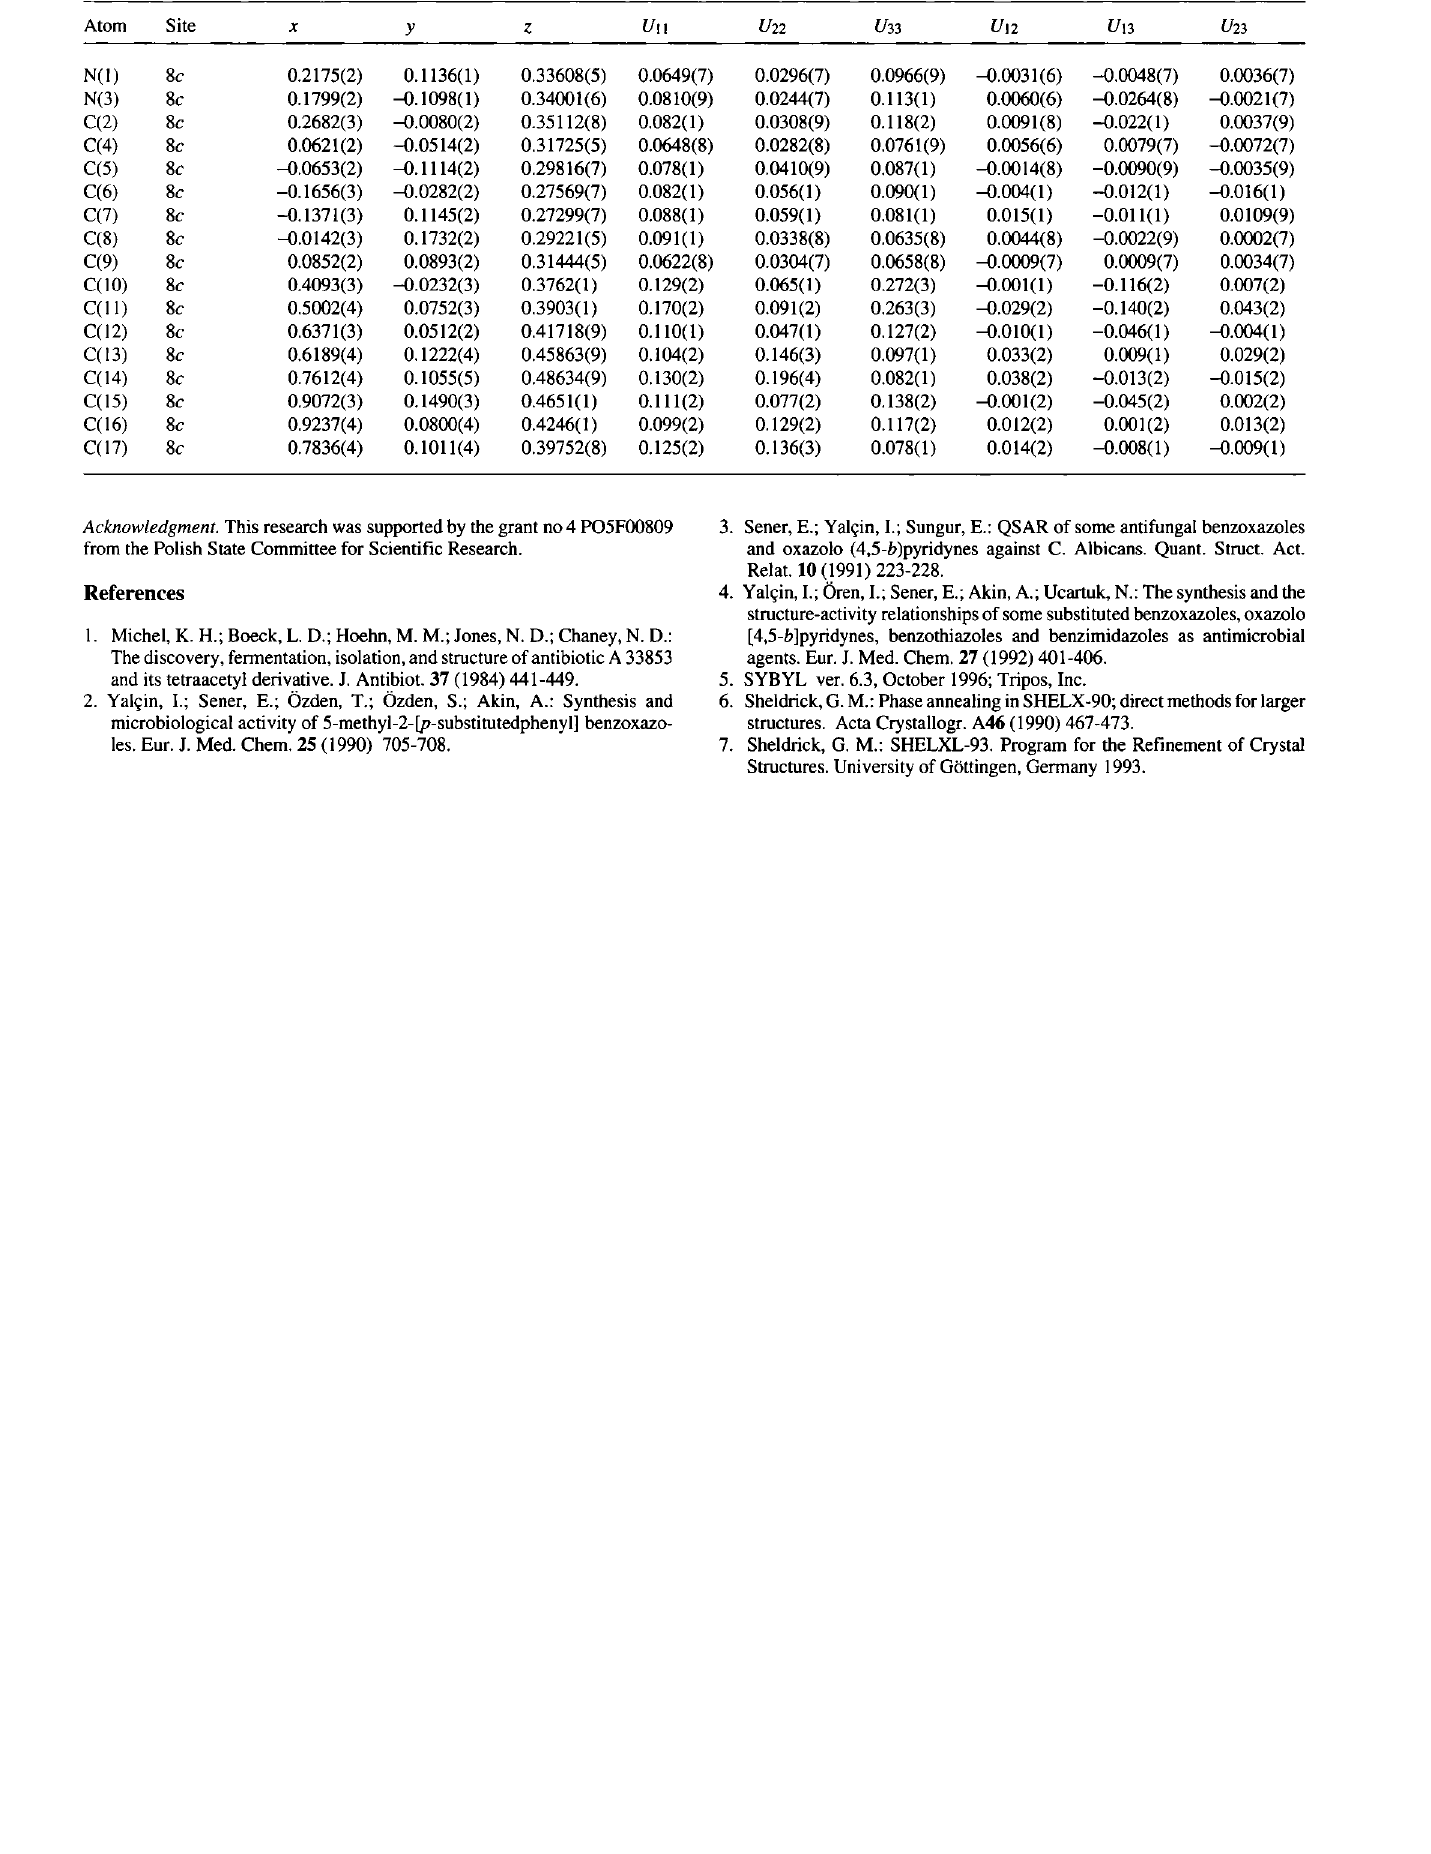
Table 3. Atomic coordinates and displacement parameters (A 2